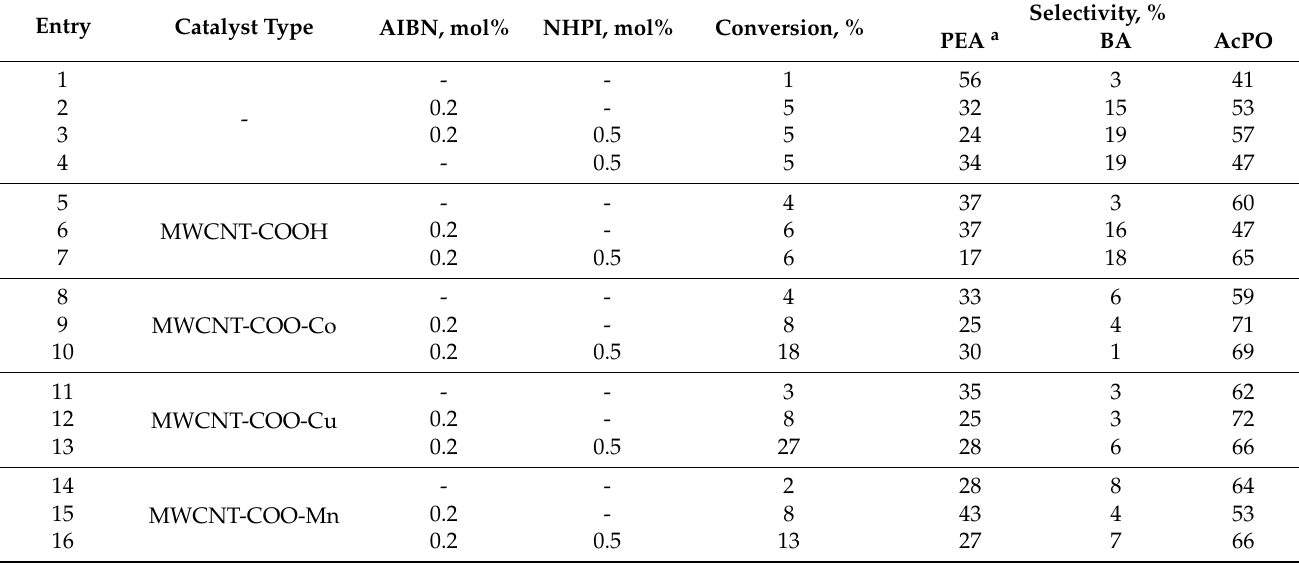
Table 1. The conversion of EB and selectivity of oxidation products with MWCNT catalysts and NHPI.